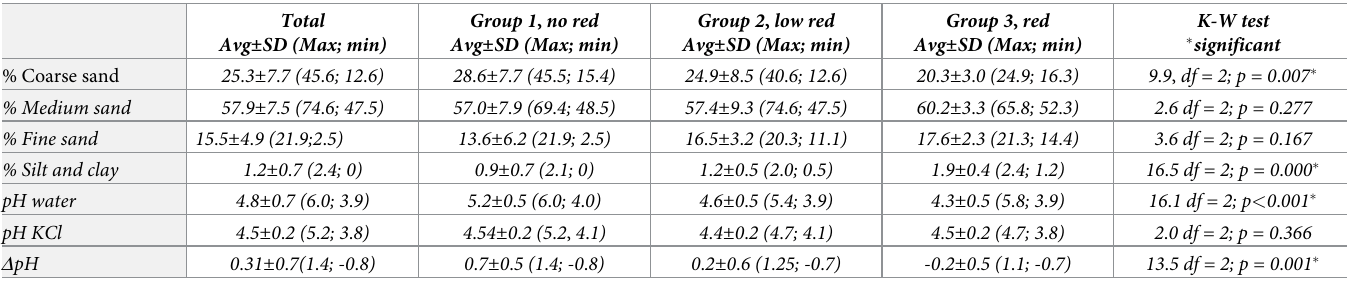
Table 1. Descriptive statistics of the grain size and pH in the three groups described and the total of the